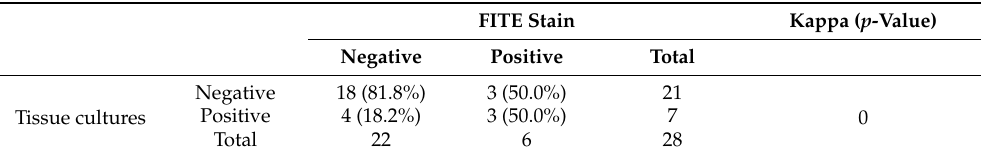
Table 4. Concordance in positivity of results between FITE stain performed on lung tissue sections and the corresponding tissue cultures (28